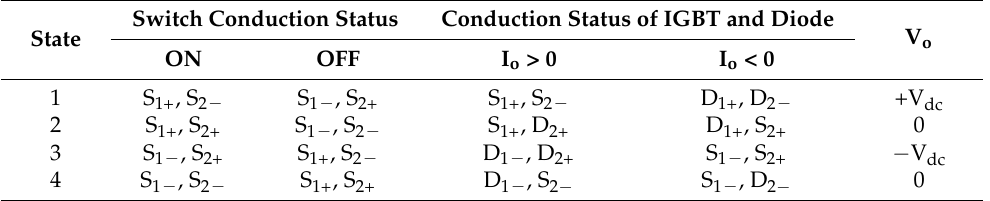
Table 1. Switch conditions in the full-bridge single-phase inverter. One of the following three voltage levels (+V dc , − V dc , or 0) is represented in the AC output voltage waveform.